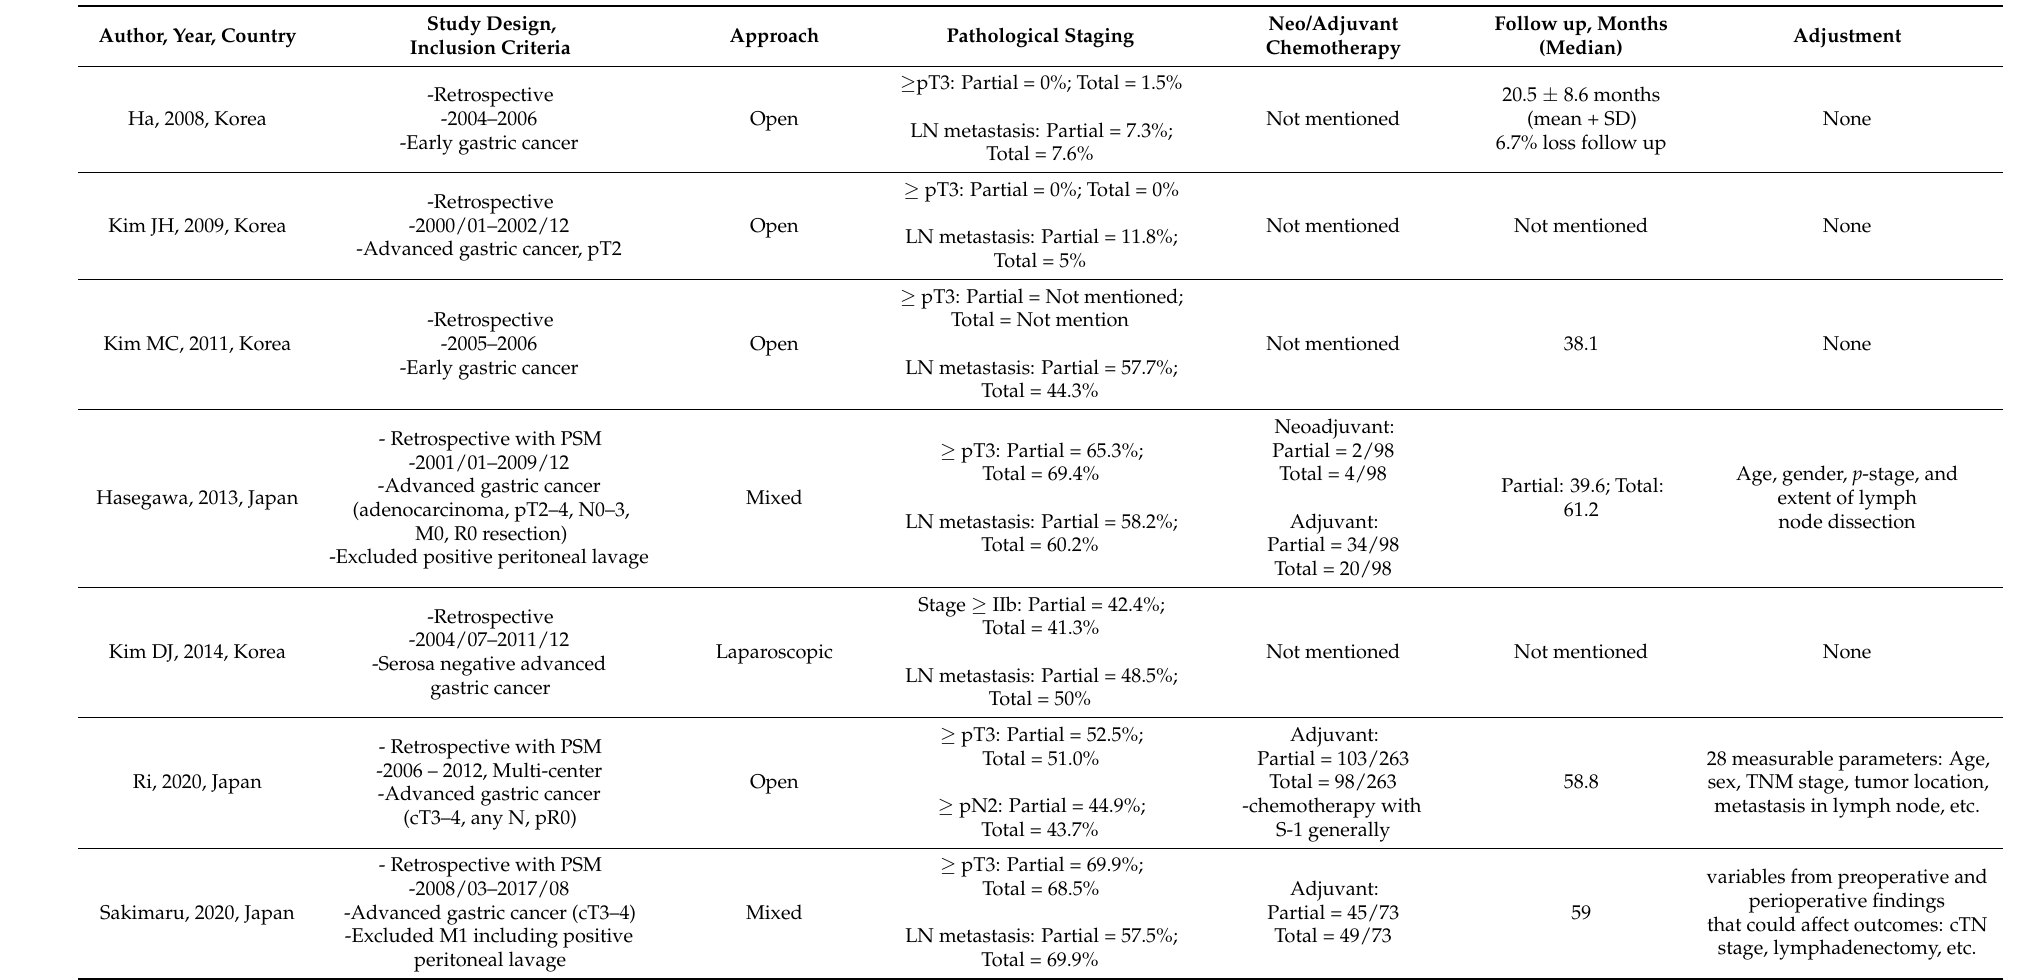
Table 1. Characteristics of the selected